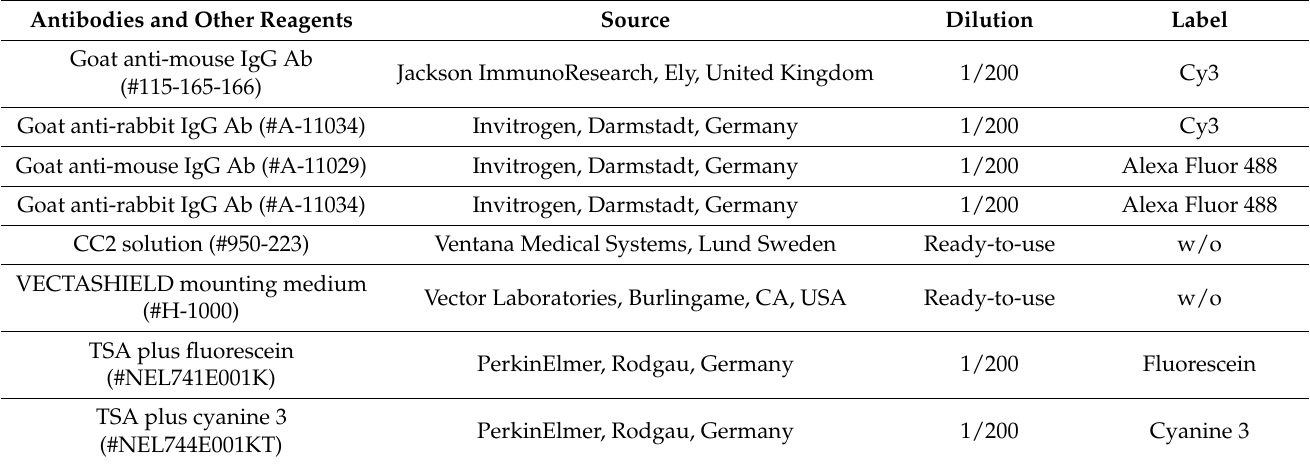
Table 2. Secondary antibodies and other